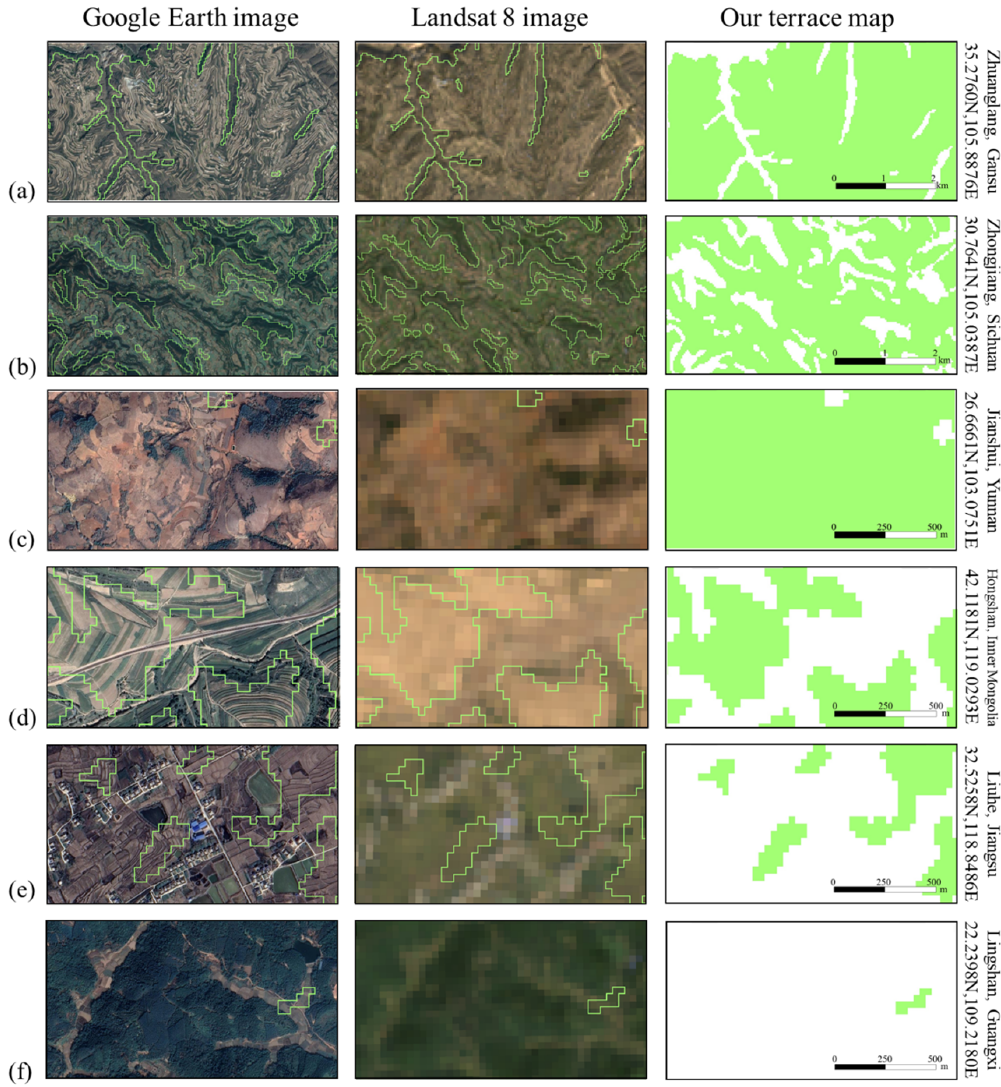
Figure 11. Selected case comparison of © Google Earth images, Landsat 8 images, and our terrace map (green represents terrace and white represents non-terrace) at six different locations (a–f) . Panels (a) and (b) are well-classified cases, and (c) – (f) are poorly classified cases. Note that they have different scales indicated on the right-hand plots. The green lines in Google Earth images and Landsat 8 images are the corresponding terrace boundaries in our terrace map. The geographic coordinate indicates the image